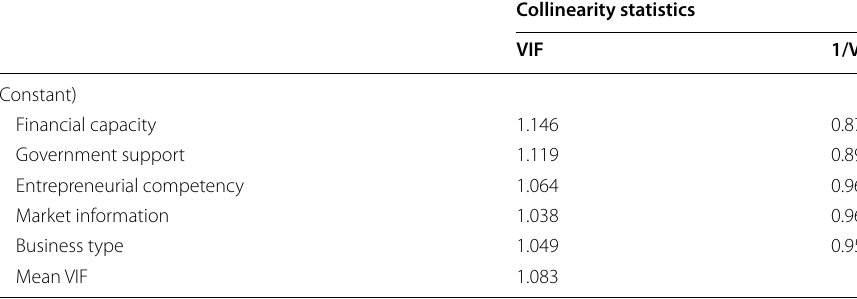
Table 3 Multicollinearity